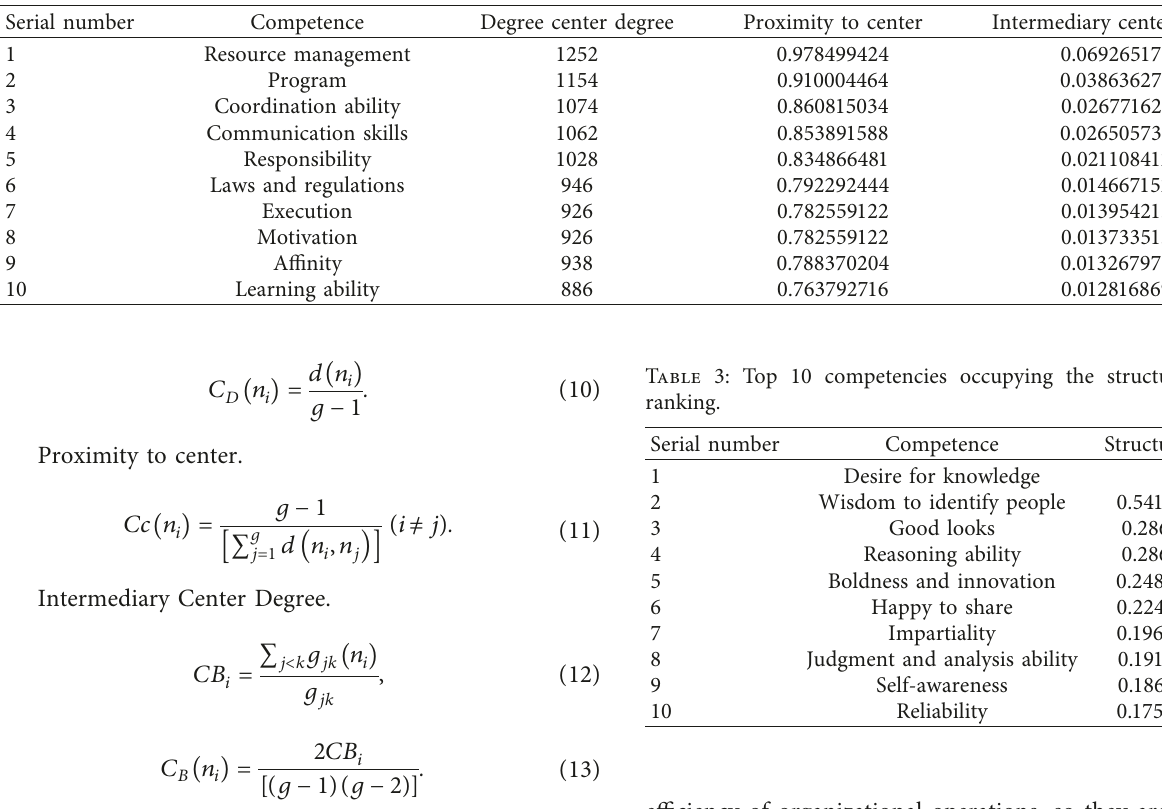
Table 2: Top 10 competencies in all categories of centrality.